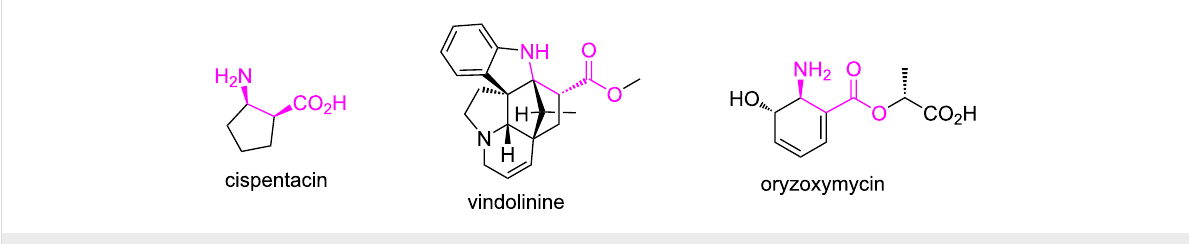
Figure 1: Examples of natural products containing β -amino acids.